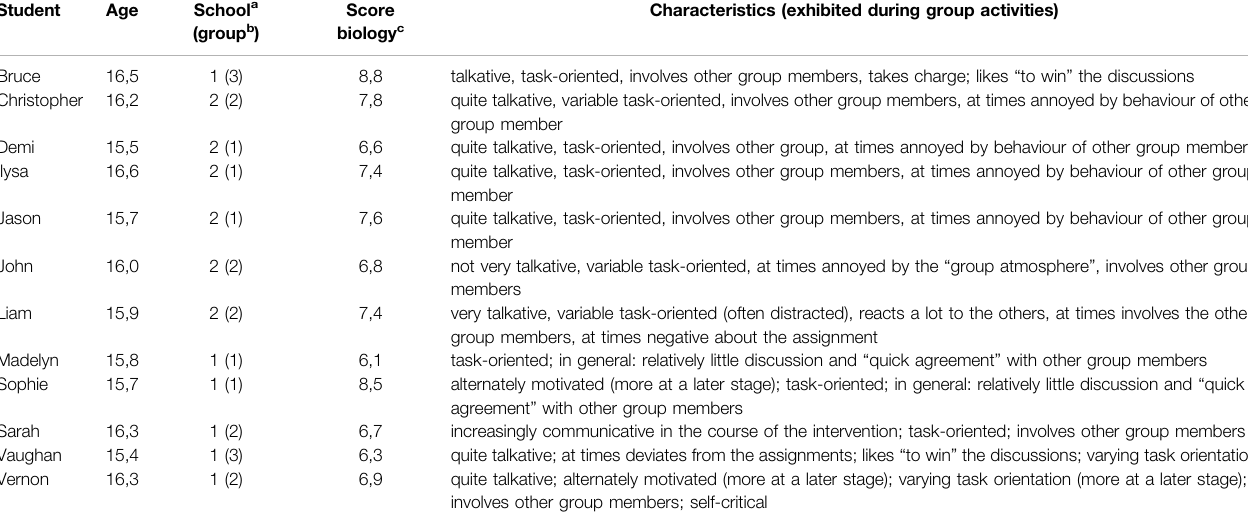
TABLE 2 | Characteristics of participants (names are pseudonyms).